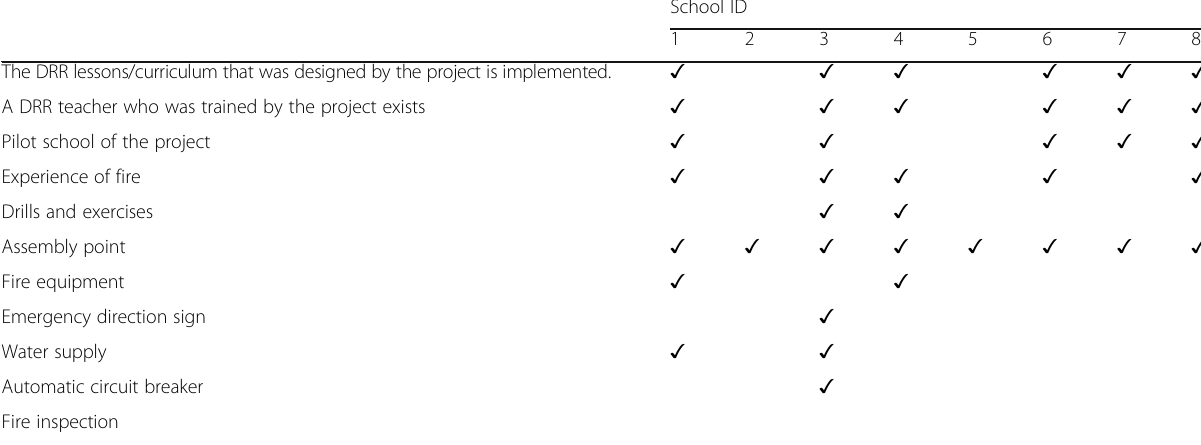
Table 3 Characteristics of study schools related to disaster risk